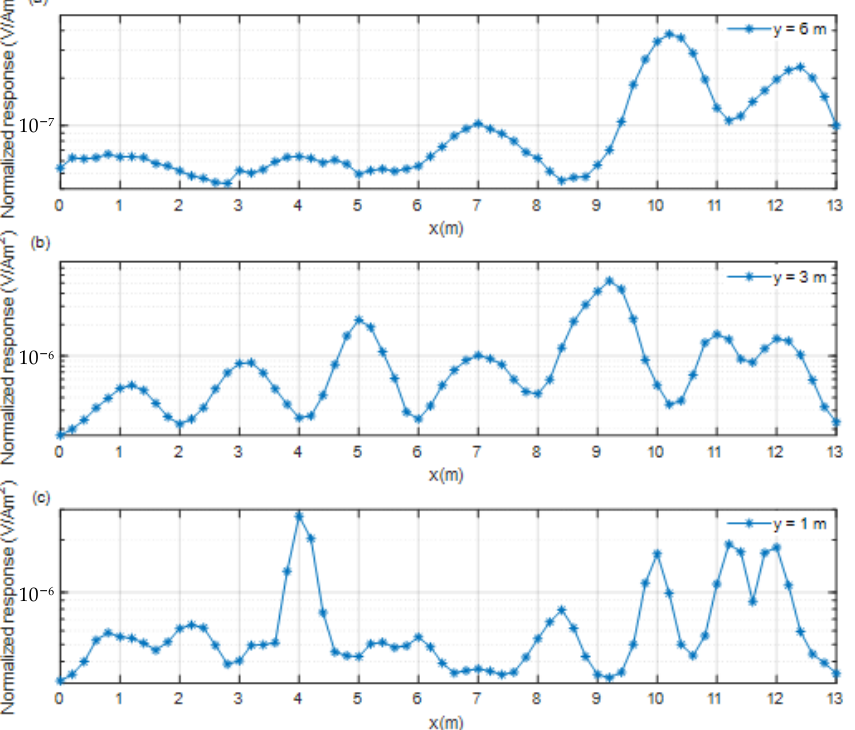
Figure 11. Responses of three survey lines. ( a ) y = 6 m, ( b ) y = 3 m, ( c ) y = 1 m. Figure 11 is the z component survey line responses of the receiving coil R5 at y = 6, 3, and 1 m. On the basis of these three survey lines, a series of measurement points are selected for cued mode. For the survey line at y = 6 m, the amplitude of target response is the smallest. The 5 positions x = 0.8, 4.0, 7.0, 10.2, and 12.4 m, which are the local maximums of survey line response, were chosen for cued mode detection. For the survey line at y = 3.0 m, the amplitude of the target response is much greater. The 7 positions